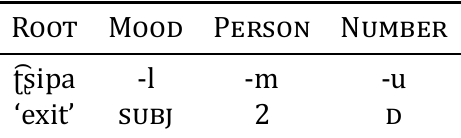
Table 2: Example OFI (mood, focal person and number marking) in contemporary